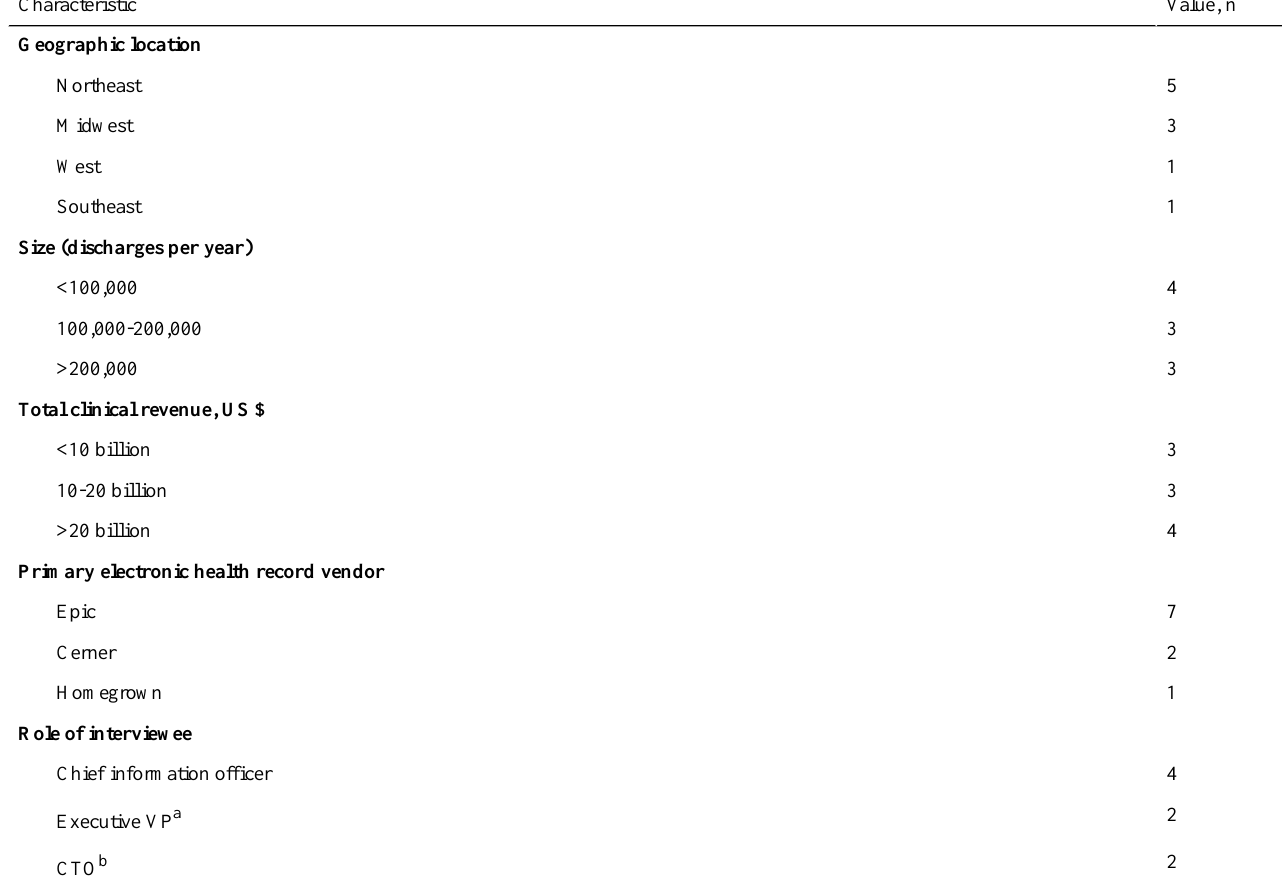
Table 1. Sample characteristics (n=10 organizations; 13